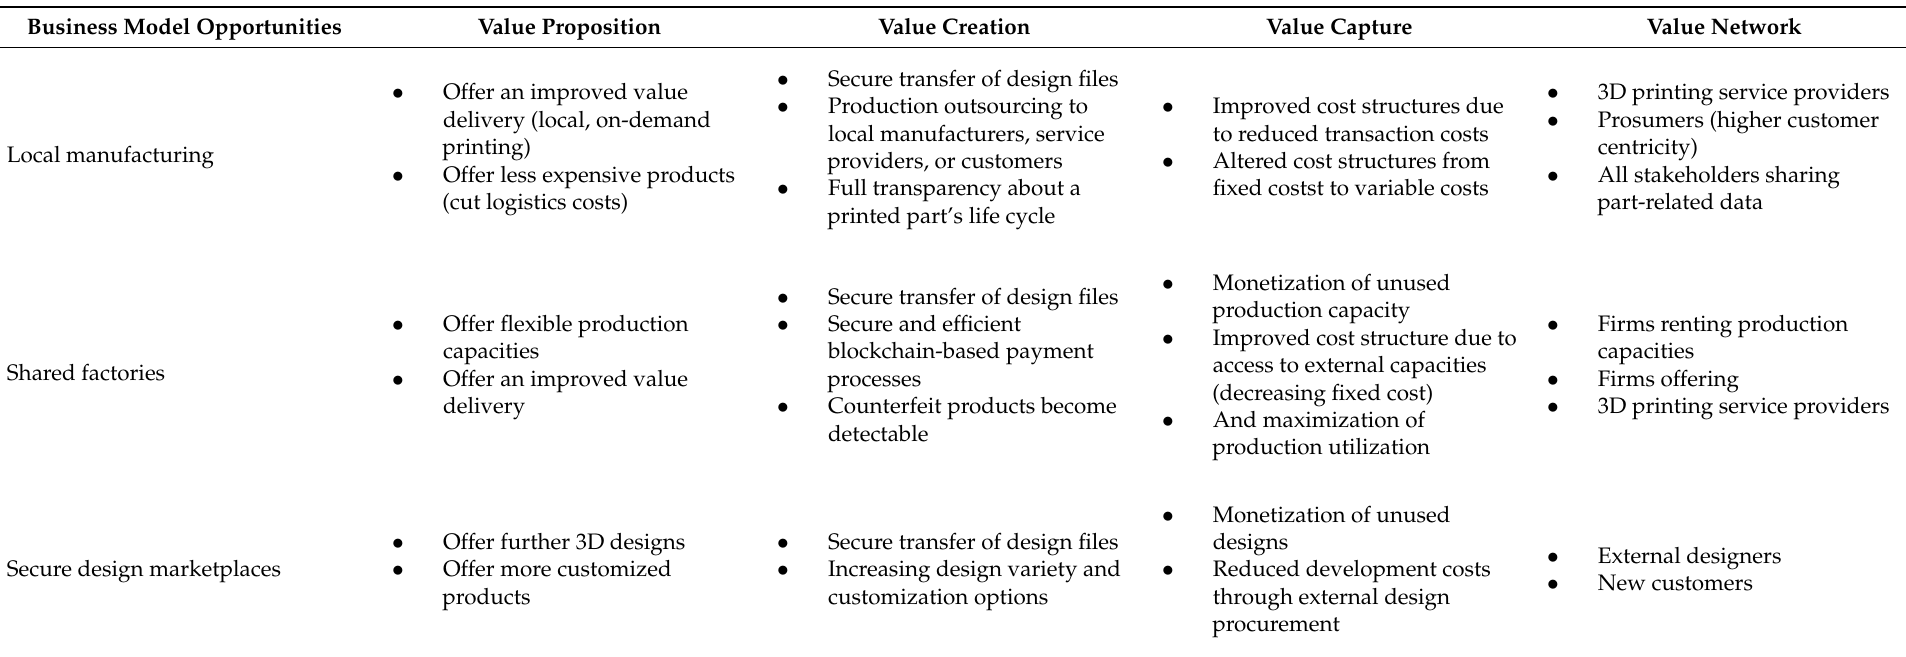
Table 1. Blockchain in 3D printing affects all business model elements